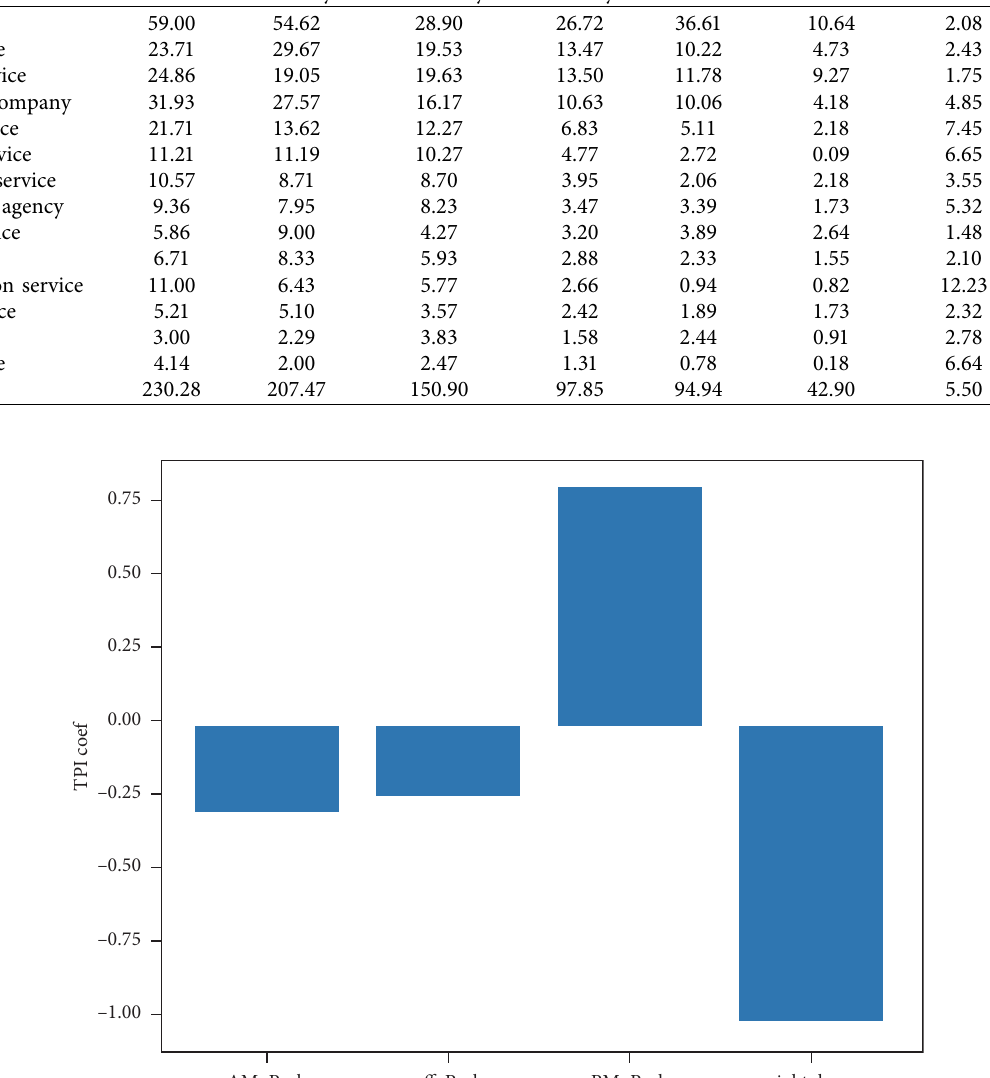
Table 5: Average number of diferent POI in diferent ranks of road. Trunk